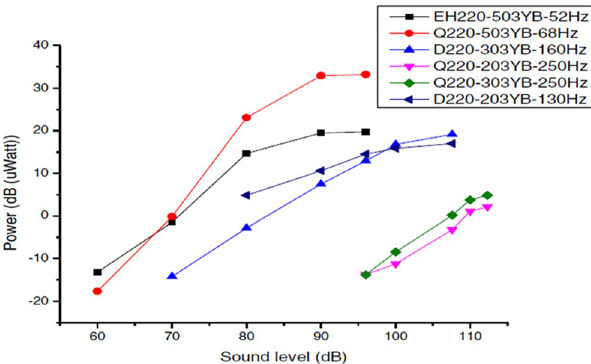
Fig 3. The graph of power versus sound level for variety type piezoelectric transducers [22].